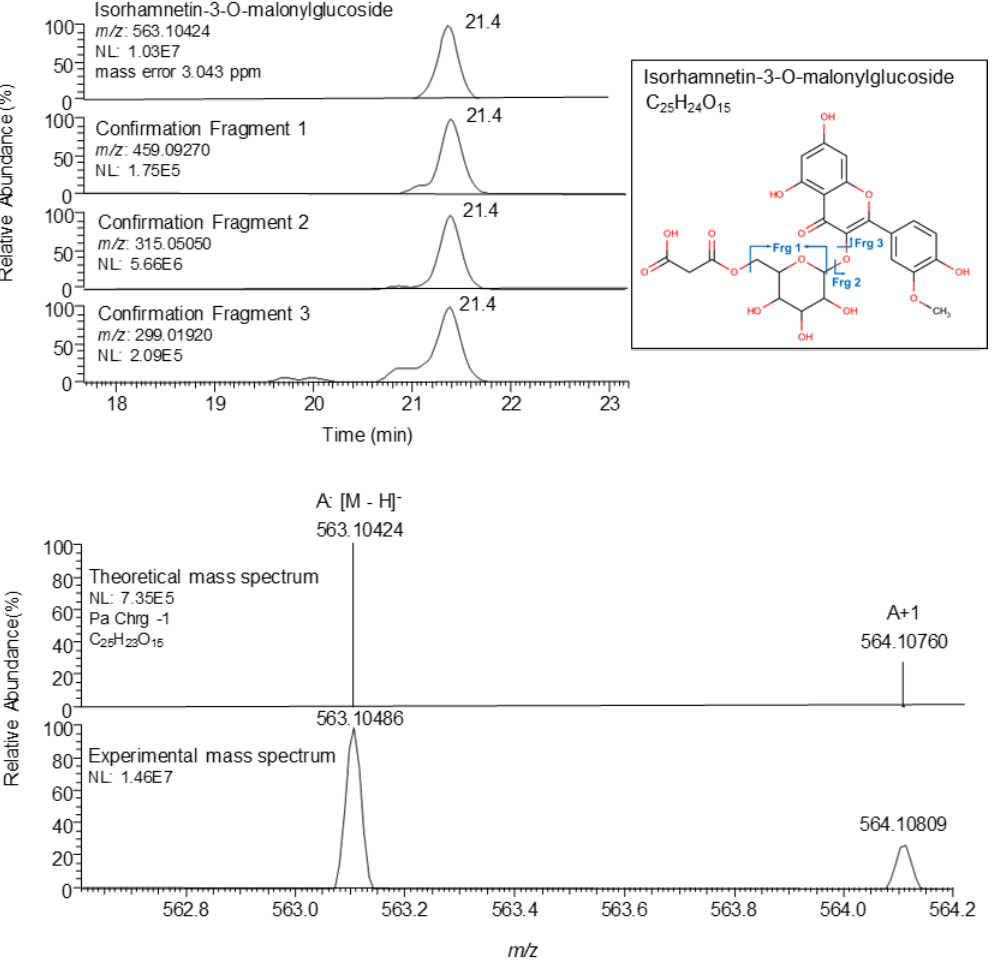
Figure 2. From top to bottom: Extracted ion chromatogram and mass spectrum of the suspected bioactive compound isorhamnetin-3-O-malonylglucoside ( m/z : 563.10424) in foliar tissues from the sampling point AL2x. NL: intensity.